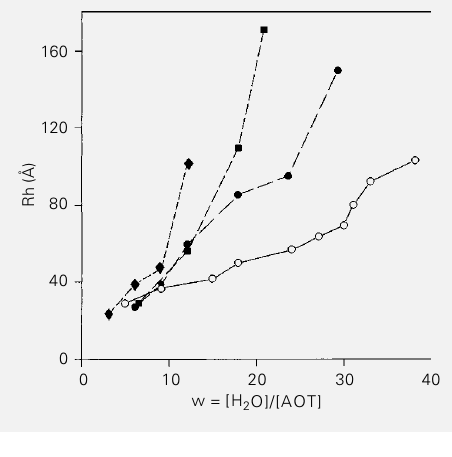
Figure 3 - Electric conductance ( k ) as a function of volume frac- tion ( f ) in the system AOT/hex- ane/water/urea. [Urea] = 0 M ( ! ); 3 M ( • ); 5 M ( (cid:224) ). T = 25 o C.